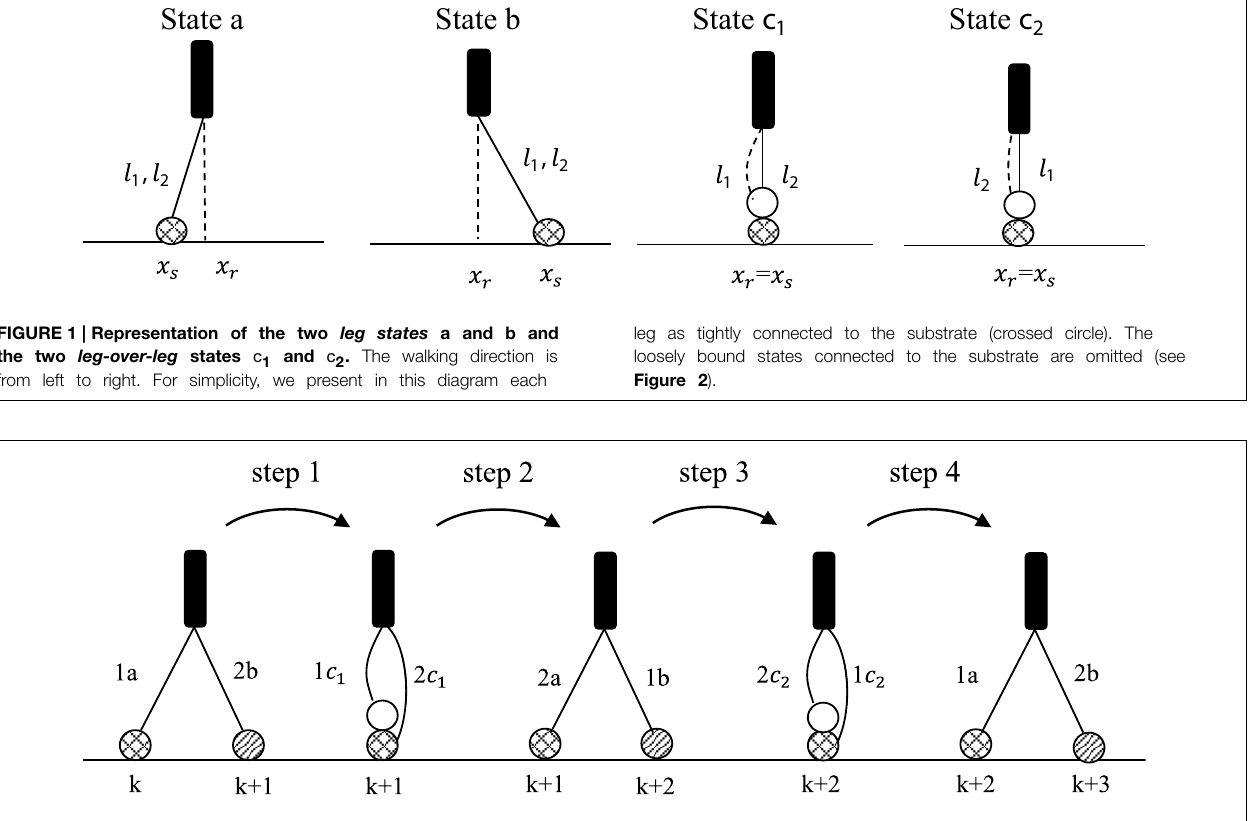
FIGURE 2 | Demonstration of one complete “leg-over-leg” cycle of a molecular robot r which walks along a substrate lane. The loosely bound states are marked by crossed circles . The tightly bound states are marked by striped circles . The first position is fixed by k